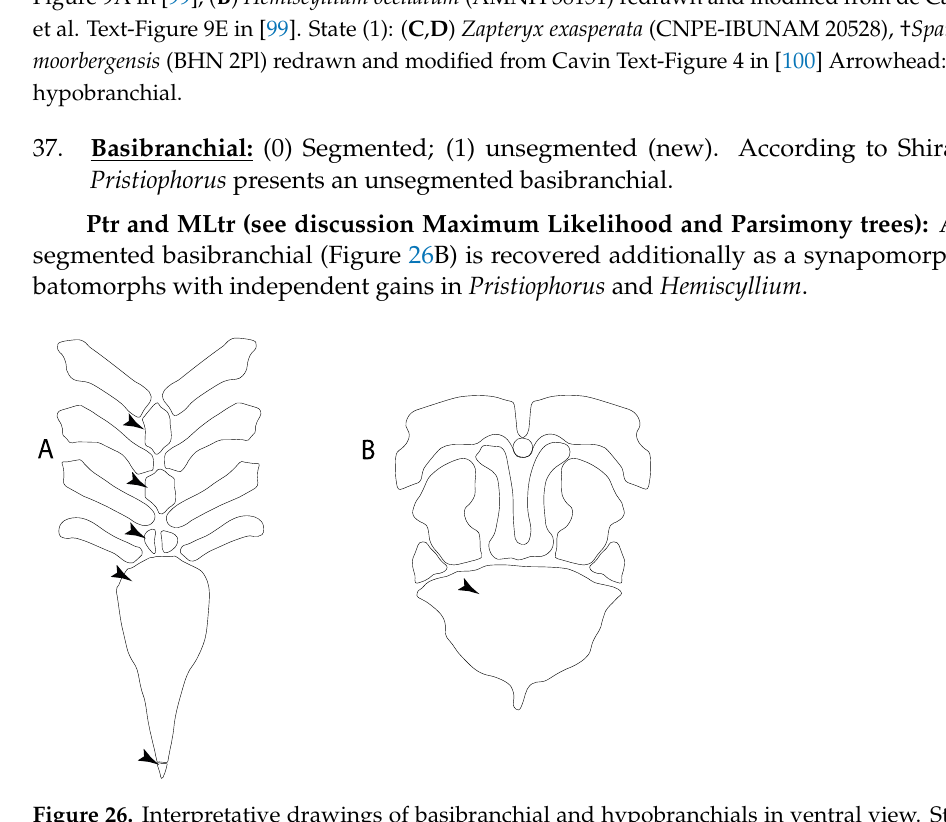
Figure 26. Interpretative drawings of basibranchial and hypobranchials in ventral view. State (1): ( A ) Heterodontus zebra (HUMZ 37666) redrawn from Shirai plate 32D in [35]. State (0): ( B ) Rhyncho- batus djiddensis (MCZ 806) redrawn and modified from Miyake and McEachran Text-Figure 5D in [101] Arrowheads: